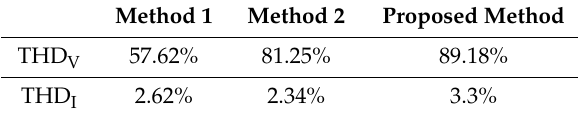
Figure 15. Experimental results of THD analysis of output load current ( I A ). ( a ) Method 1, ( b ) method 2, ( c ) proposed method. Table 5. THD analyses of output phase voltage (THD V ) and output load current (THD I ).